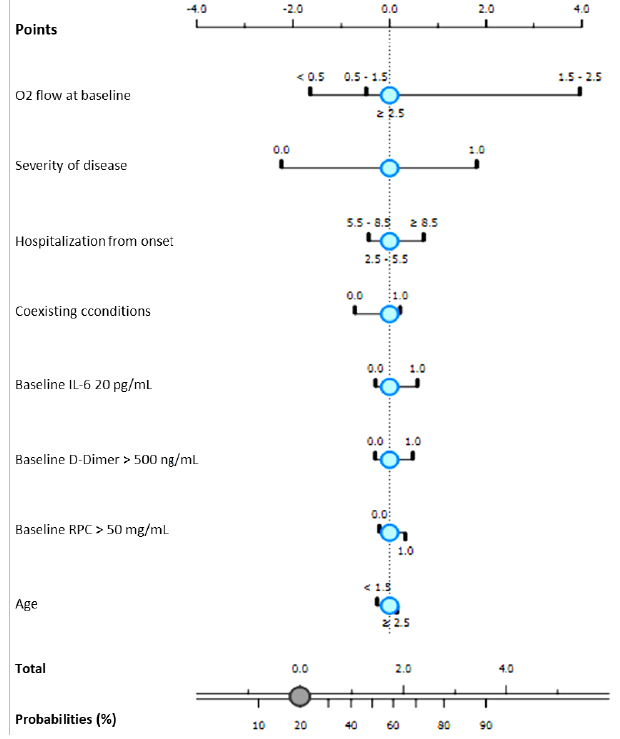
Figure 2. Probability of progression to non invasive ventilation according to Bayesian classifier (NBC). Patients treated with Remdesivir hospitalized during the second COVID-19 wave (September